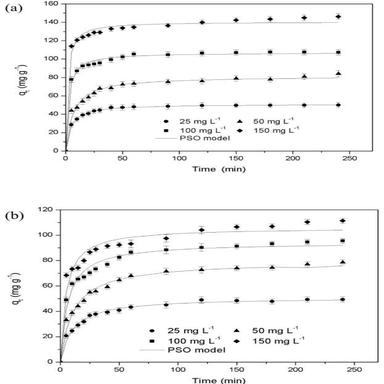
Kinetic curves for emerging contaminants adsorption on NiAC (a) ibuprofen (b) ketoprofen (C0 ¼ 25e150 mg L1 , dosage of 0.5 g L1 , 298 K, 125 rpm, 4 h, pH 2).